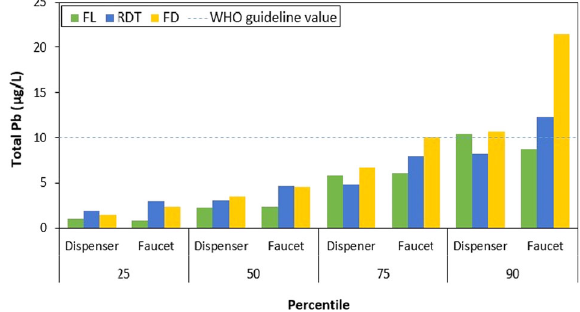
Fig. 5 Cumulative Pb levels. Total Pb levels at 25th, 50th, 75th and 90th percentiles in dispenser and faucet samples using fl ush (FL), random daytime (RDT) and fi rst draw (FD) sampling protocols. Dotted line refers to the WHO guideline value of 10 μ g/L for Pb in drinking